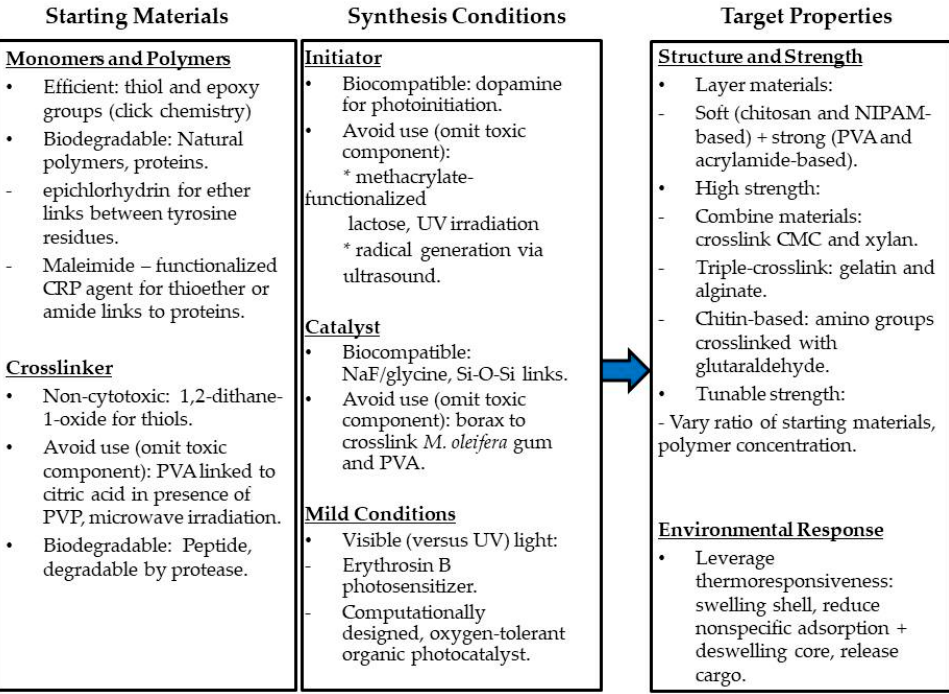
Figure 17. Selected water-based hydrogel synthesis strategies for biological applications. CRP = controlled radical polymerization; PVA = poly(vinyl alcohol); PVP = polyvinylpyrrolidone; CMC = carboxymethyl cellulose.